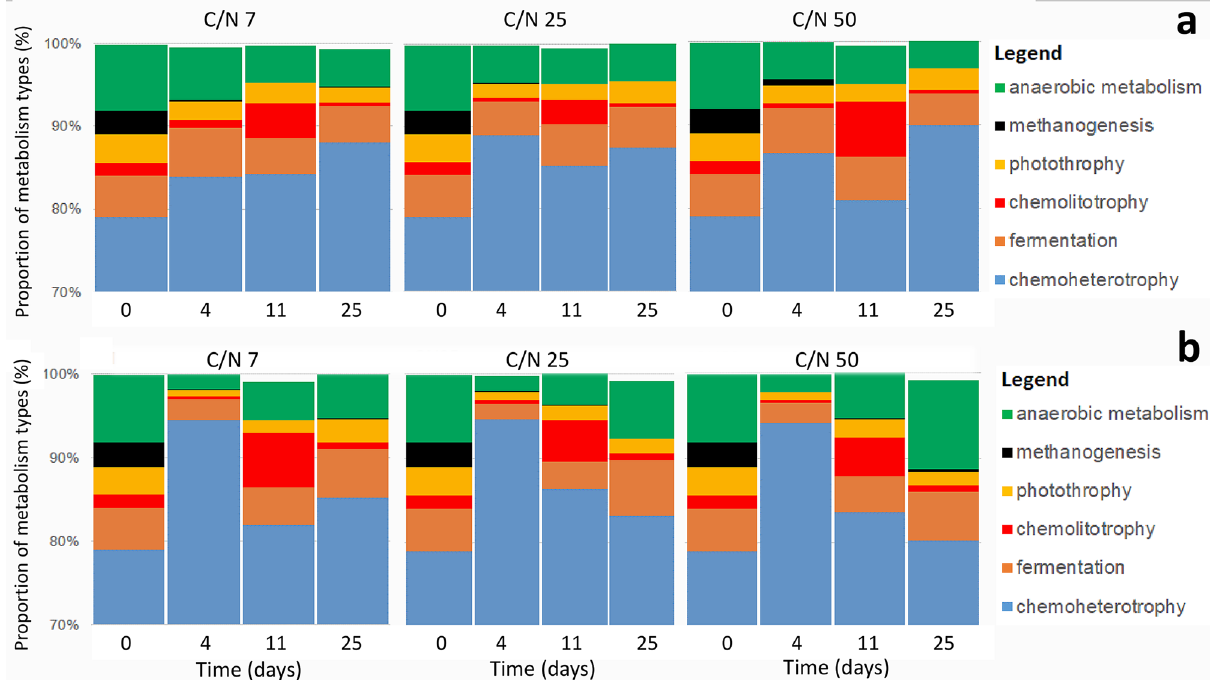
Figure 6. Temporal development of metabolism types of prokaryotic community in samples amended by artificial exudates with different C/N ratios ( A ) in concentration of 2% of total DOC and ( B ) in concentration of 5% of total DOC during 25 days incubation. Type of metabolism was assigned according to known bacterial genomes using FAPROTAX algorithm (Louca et al. 47